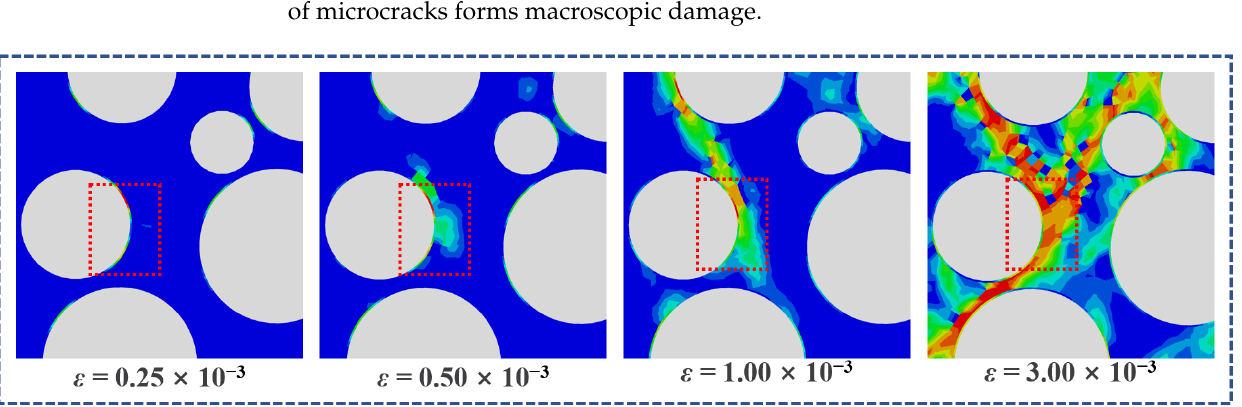
Figure 23. Evolution of ITZ failure under compression.